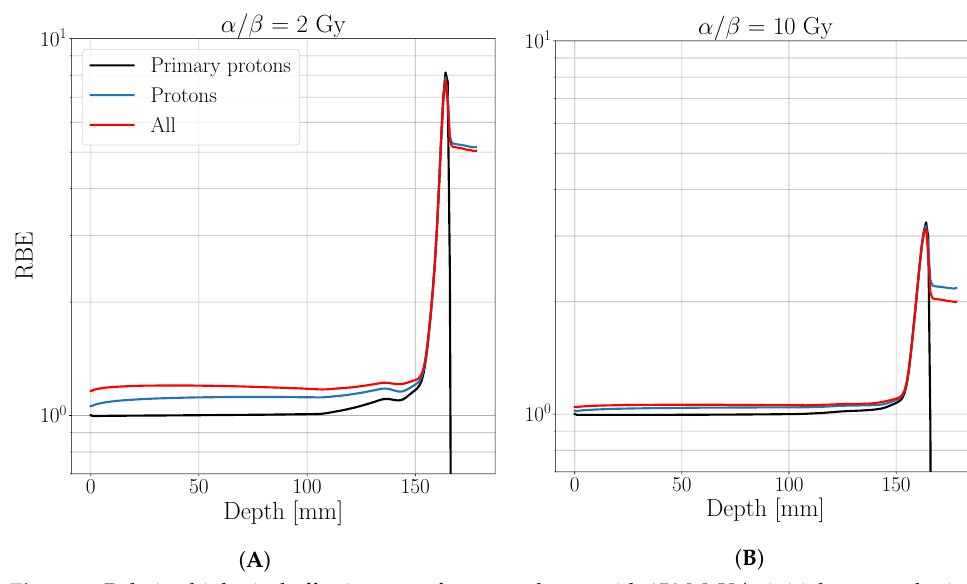
Figure 3. Relative biological effectiveness of a proton beam with 150 MeV/u initial energy obtained by considering the contribution of only primary protons (black), all protons (blue) and all particles (red). The evaluation is reported in semi-log scale for a tissue characterized by an α / β of 2 Gy ( A ) and a tissue characterized by an α / β of 10 Gy ( B